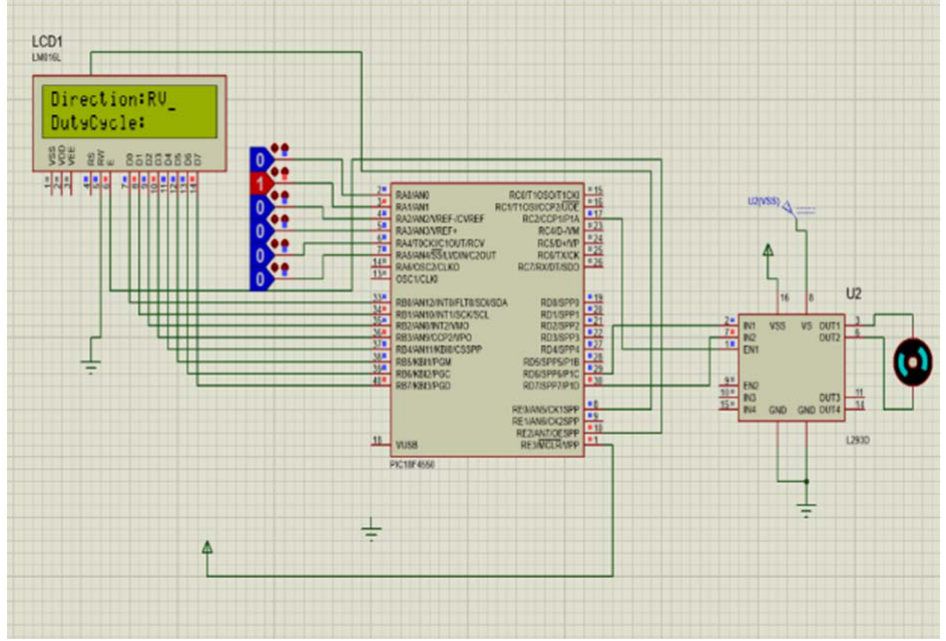
Figure 7. Analysis of control through